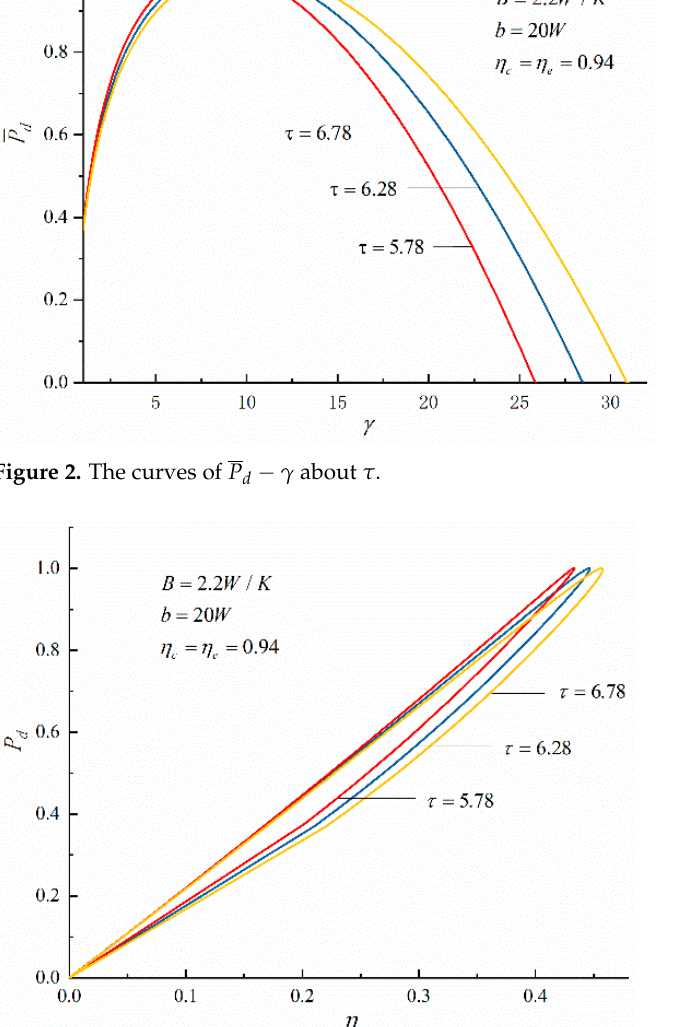
Figure 3. The curves of